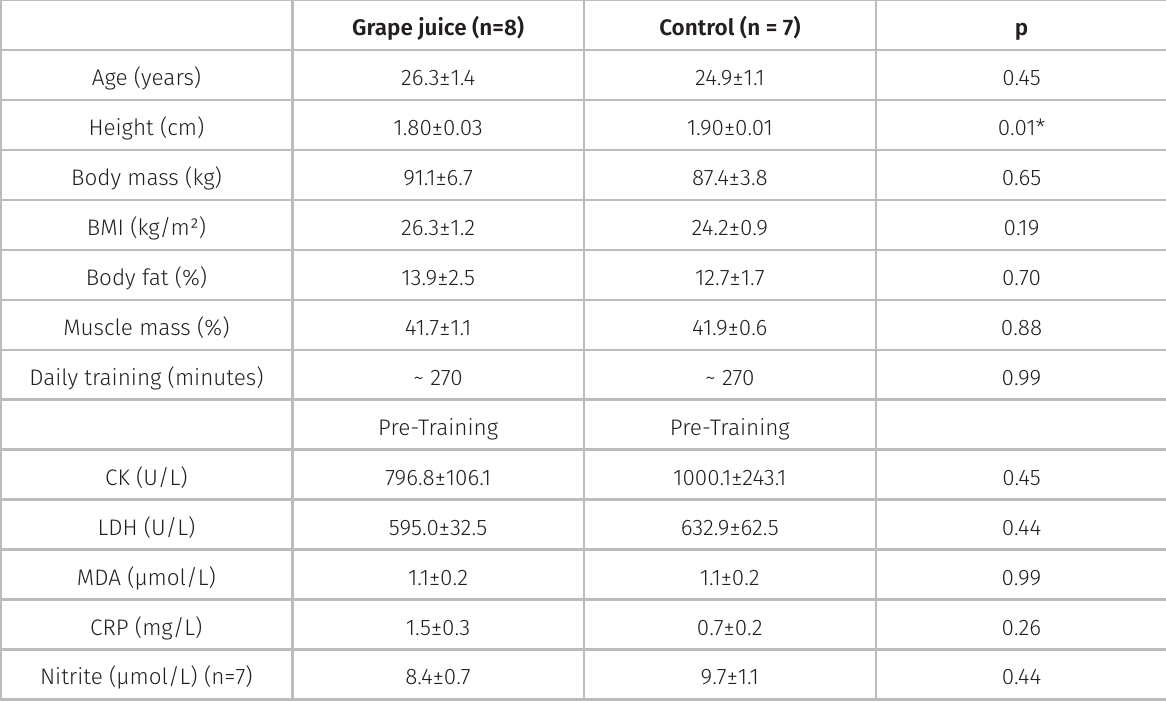
Table I. Pre-training characteristics of the